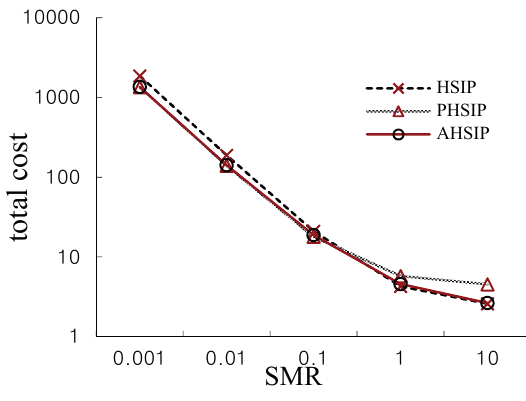
Figure 9. Total cost according to